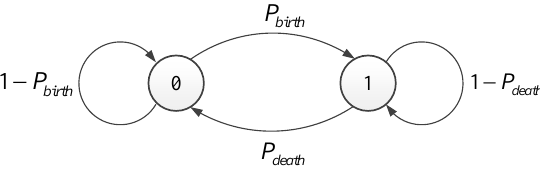
Figure 1. Diagram of state